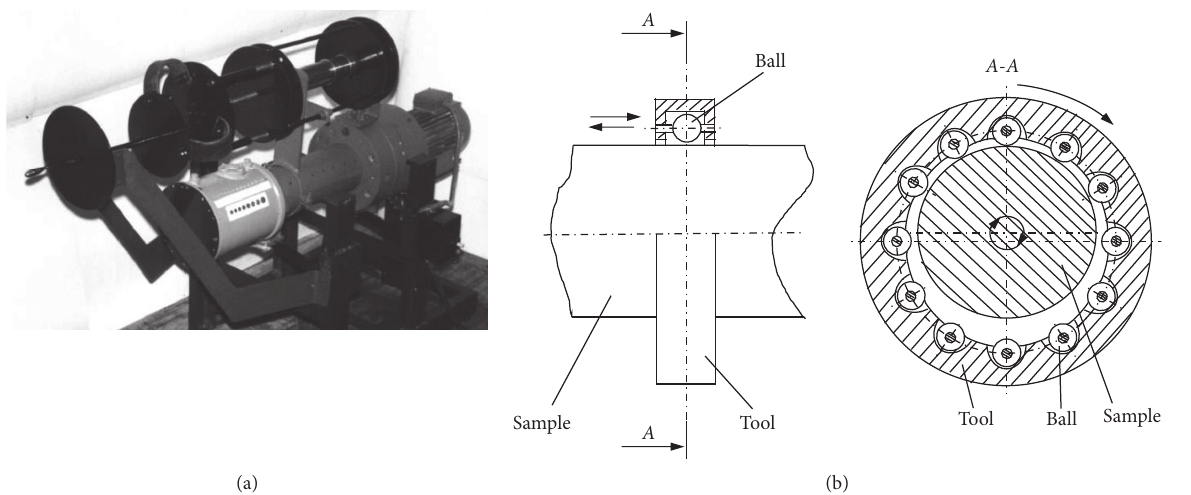
Figure 1: Installation for vibration-centrifugal hardening (a) and schematic representation of a process